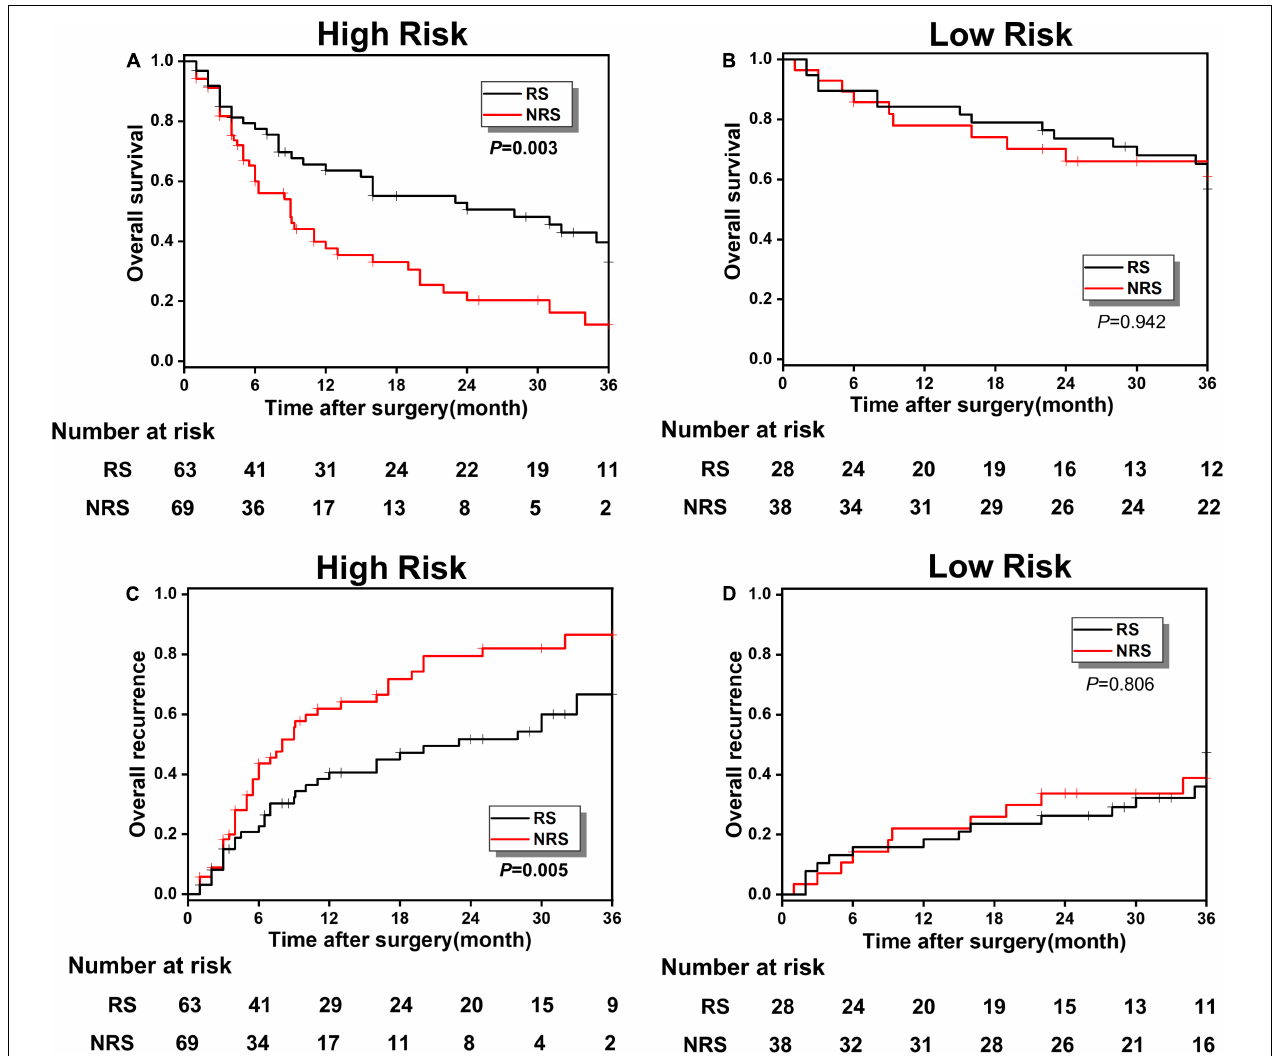
FIGURE 5 | (A,B) The OS comparison between radical surgery (RS) and non-radical surgery (NRS) subgroups in the low-risk and high-risk groups; (C,D) the overall recurrence comparison between the RS and NRS subgroups in the low-risk and high-risk groups.